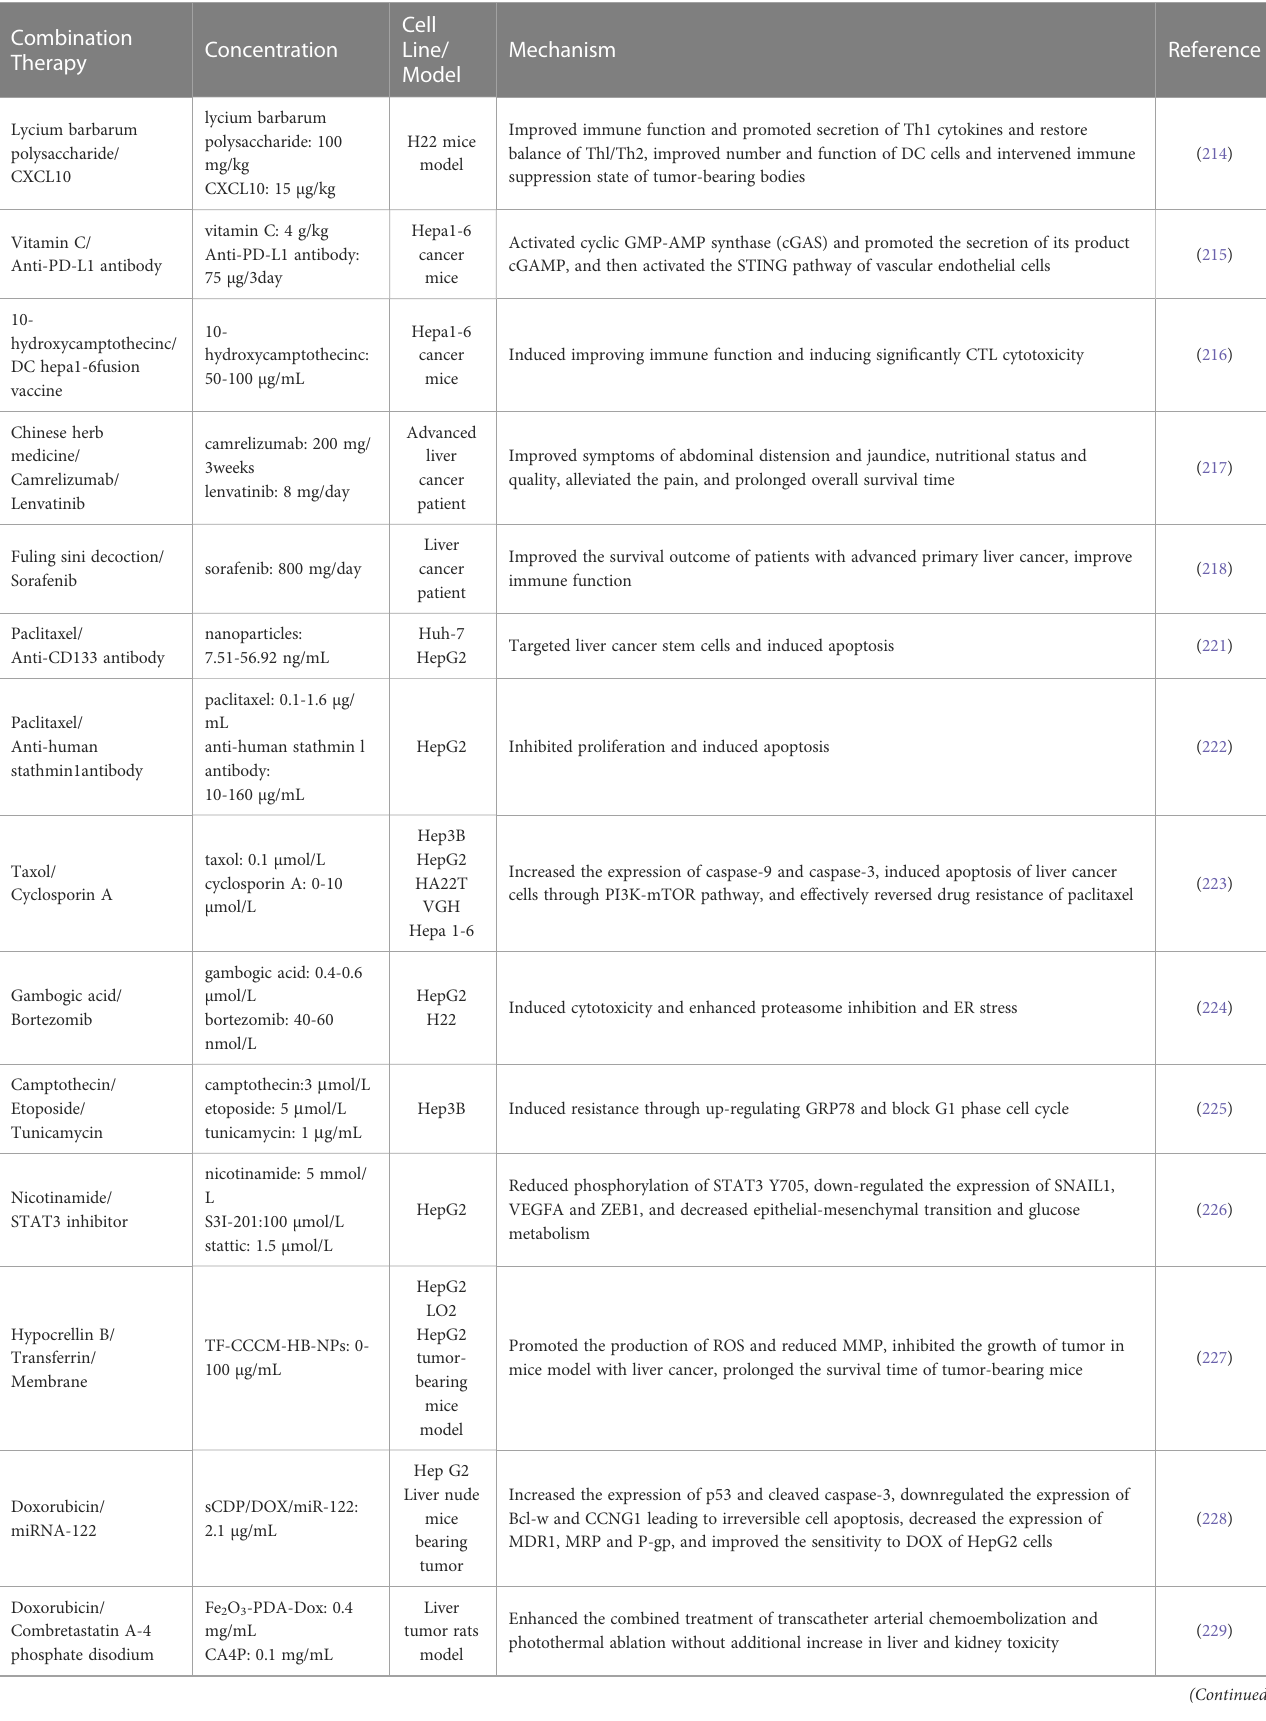
TABLE 3 Effect and mechanism of plant-derived natural products in combination with immunotherapy. Combination